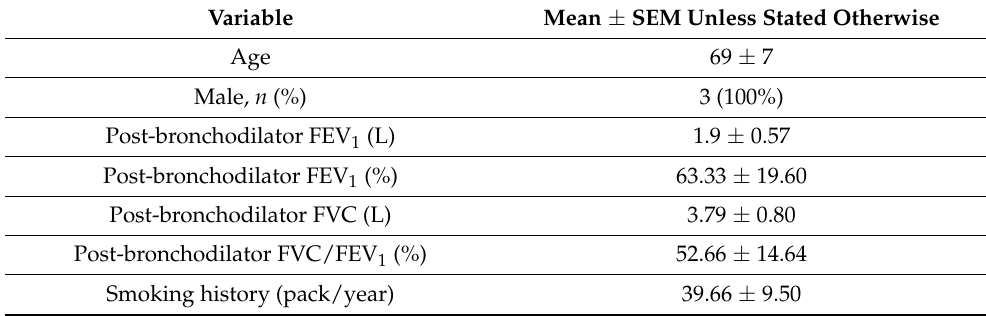
Table 1. Demographics and clinical characteristics ( n =